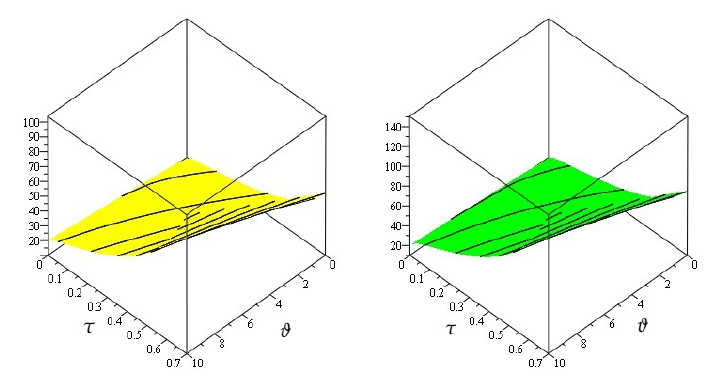
Figure 2. The analytical solutions of ν ( ϑ , ζ , τ ) at (cid:36) = 0.6 and 0.4 of Example